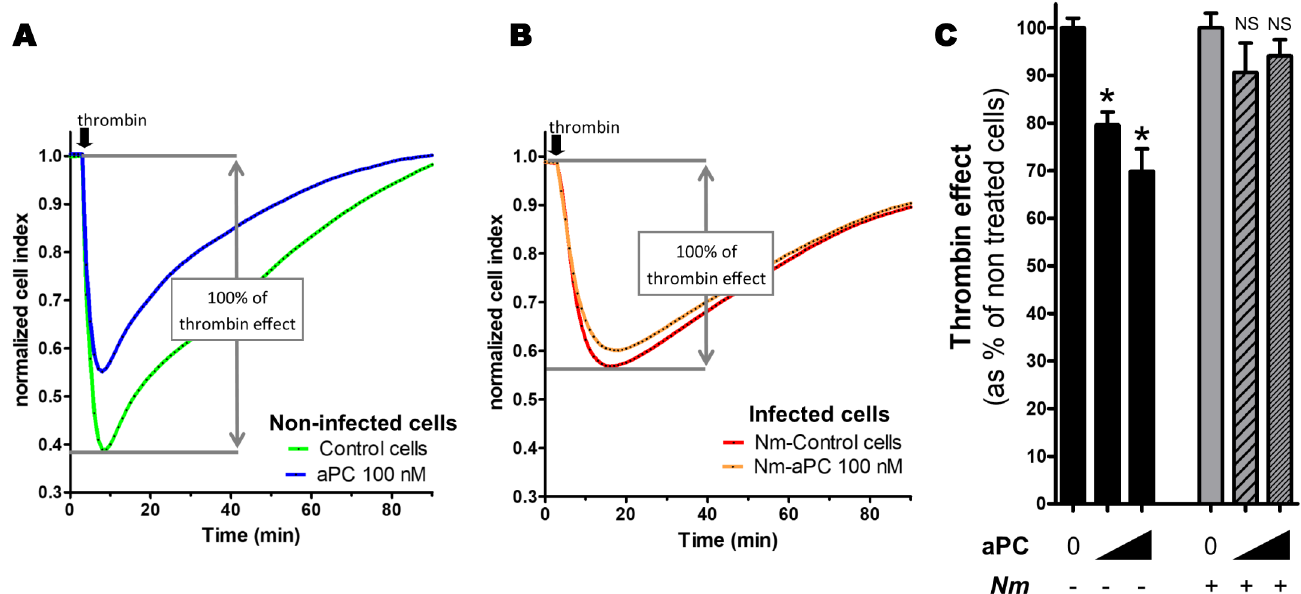
Fig 8. Meningococcal infection suppresses the aPC barrier protective effect. The barrier permeability of HDMEC monolayers was assessed using the iCELLigence system that continuously measures the electrical impedance. Cells were infected with a wild type meningococcus for 4 hours or left non-infected. After the infection, cell media were replaced, and cells were treated with aPC (50 nM or 100 nM) or left untreated. After 2 hours, thrombin (1 nM) was added and electrical impedance (Cell Index) was measured every minutes. ( A ) Representative data showing the effect of thrombin on monolayers impedance when HDMEC cells were treated (blue) or not (green) with aPC (100 nM). ( B ) Representative data showing the effect of thrombin on monolayers impedance when HDMEC cells were treated (orange) or not (red) with aPC (100 nM). ( C ) Loss of CI induced by thrombin expressed as % of non-treated cells. Data are mean (+/-SEM) from three independent experiments. For each condition (non-infected/infected) an analysis of variance (ANOVA) was done followed by multiple comparisons by t- tests with a correction of Bonferonni. (cid:3) : p < 0.01 compared to non-treated cells. NS: non significant ( p > 0.05).